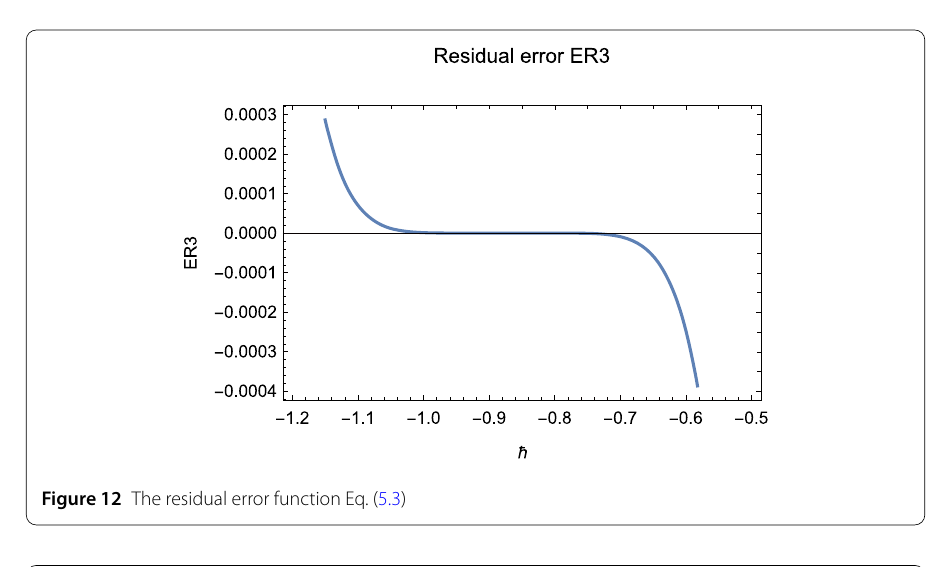
Figure 11 The residual error function of Eq. (5.2)